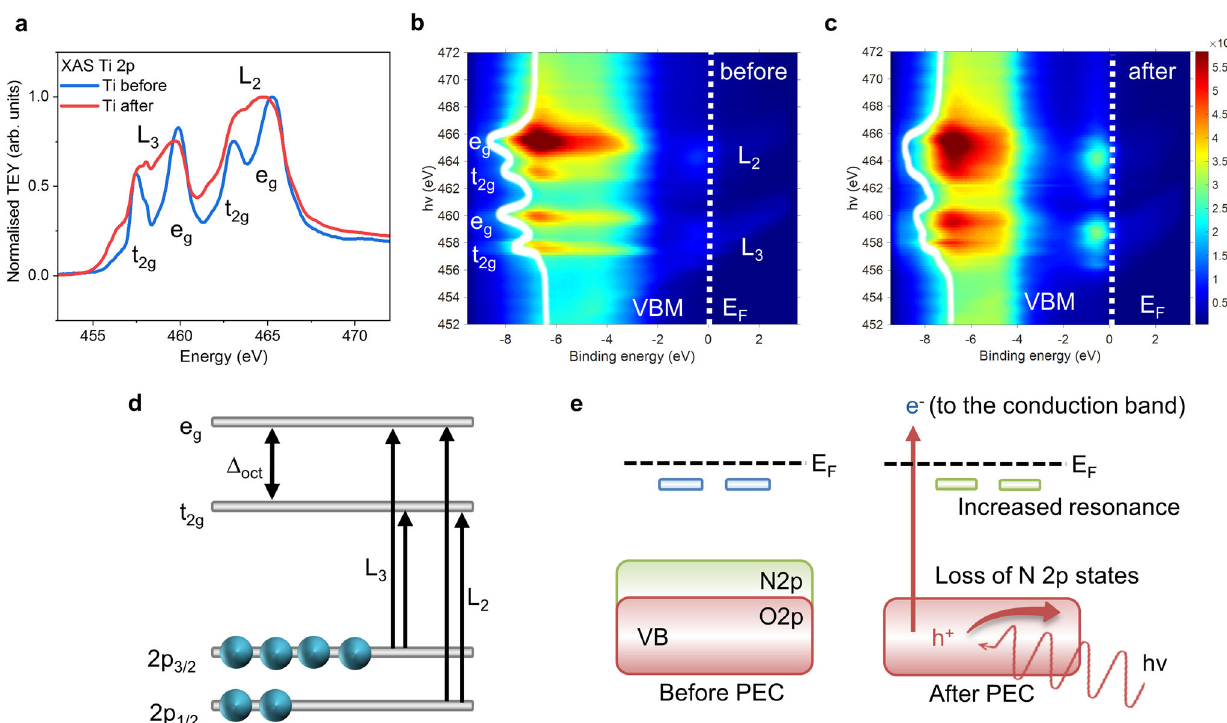
Fig. 2 Titanium B cation resonant SX-ARPES. a XAS spectra for LTON showing the Ti L 2 and L 3 edge before and after the PECR, shown in blue and red, respectively. b , c Maps of angle-integrated ResPE intensity across the Ti L 3 and L 2 before ( b ) and after ( c ) the PECR. The solid white lines are the XAS spectra overlaid from ( a ). The white dashed line marks the E F (0 eV). d Schematic representation of the transition of the L 3 and L 2 absorption bands. e Graphic representation for the observed changes occurring to the band structure of the surface layers of the LTON photocatalyst, where hv and VB denote the visible-light photons and the VB,